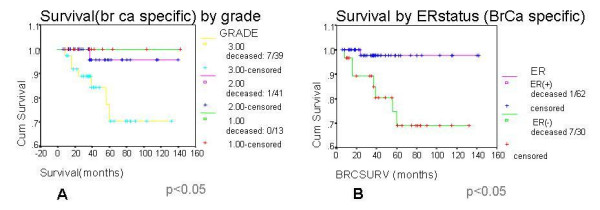
A) Breast cancer specific survival according to histological grade treated by breast conserving surgery B) Breast cancer specific survival according to oestrogen receptor (ER) status treated by breast conserving surgery.